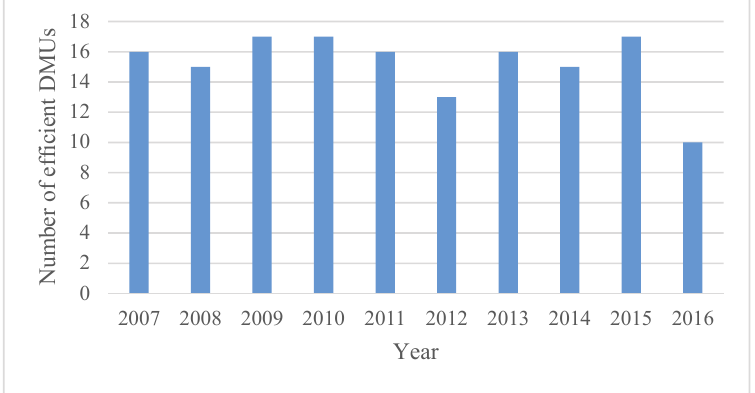
Fig. 2. Total Number of Efficient DMUs